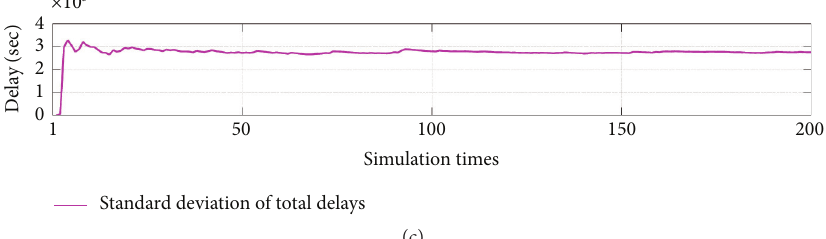
Figure 14: Standard deviation of the total delays with different simulation times (a) when 1000 cars arrive, (b) when 2000 cars arrive, and (c) when 3000 cars arrive.